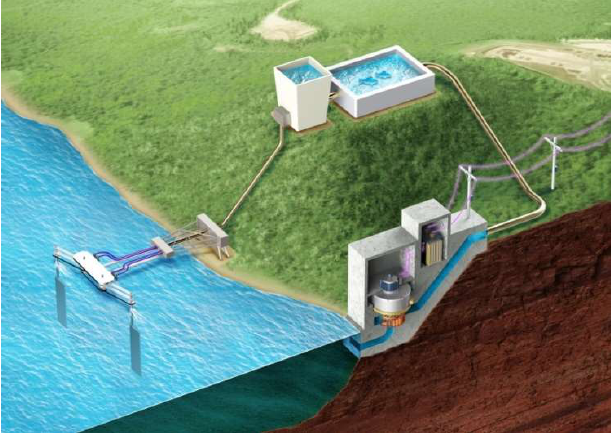
Figure 11. Schematic of the tidal current and pumped storage hybrid power generation system.